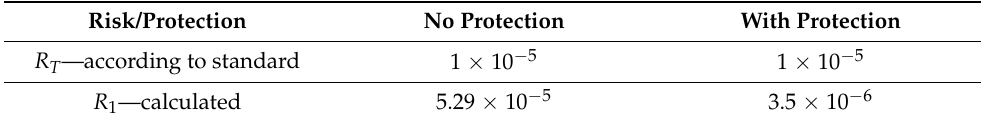
Table 4. Risk R 1 —loss or injury of human life in structure. Risk/Protection